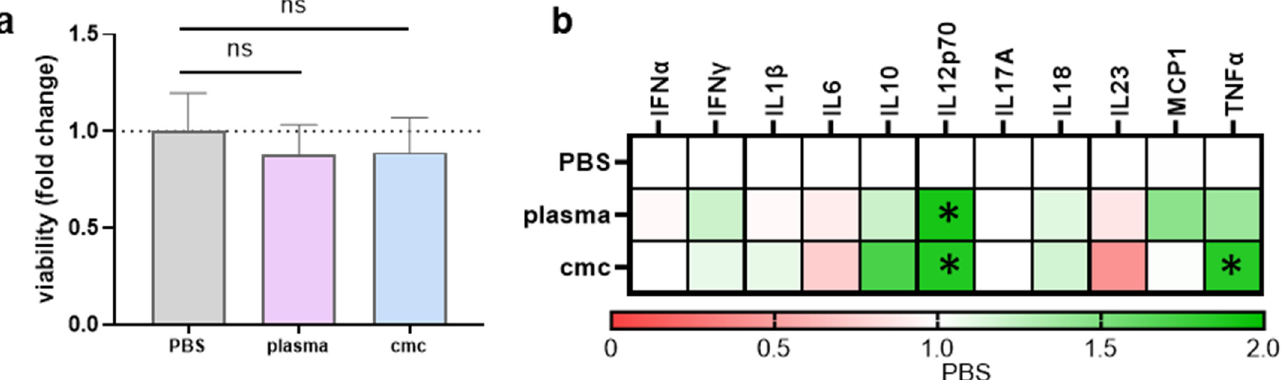
Figure A1. ( a ) Viability of THP ‐ 1 cells after incubation with protein ‐ free PBS or gas plasma ‐ oxidized protein ‐ free PBS; ( b ) cytokine secretion of protein ‐ free oxPBS ‐ treated THP ‐ 1 cells normalized to secretion following protein ‐ free PBS. Data are the mean of at least three independent experiments. Statistical analysis was performed using two ‐ way analysis of variances; for ANOVA: F = 2.6 ( a )/3.5 ( b ), df = 2 ( a )/2 ( b ). ns = not significant; * denotes significant differences ( p < 0.05).